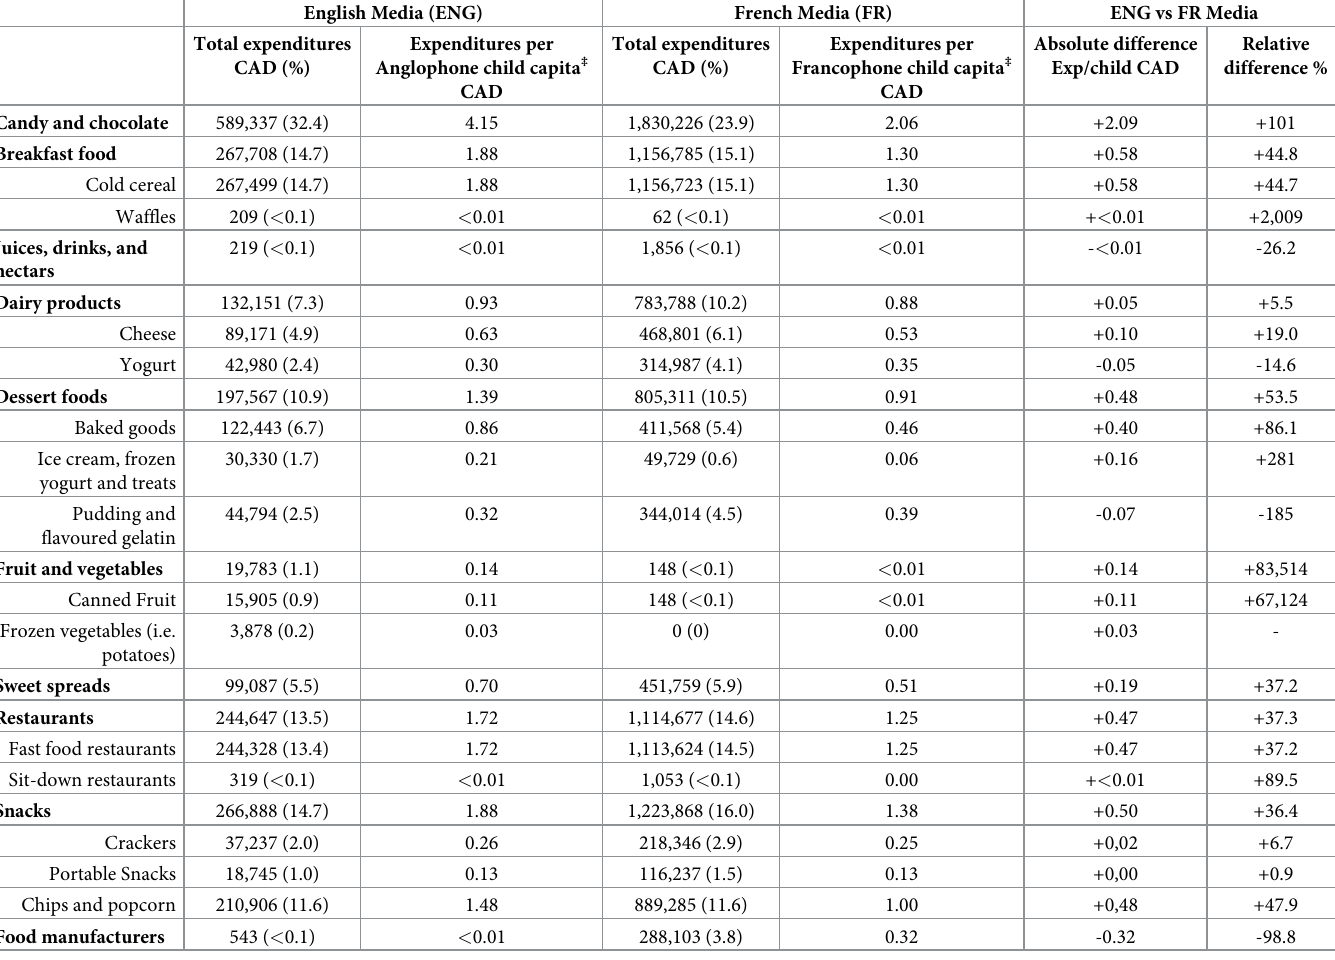
Table 7. Advertising expenditures on child-targeted products † in Quebec in 2019, by language and food